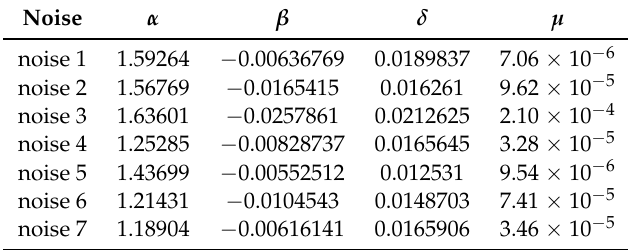
Table 2. The parameters estimation of α stable distribution of noise in China.